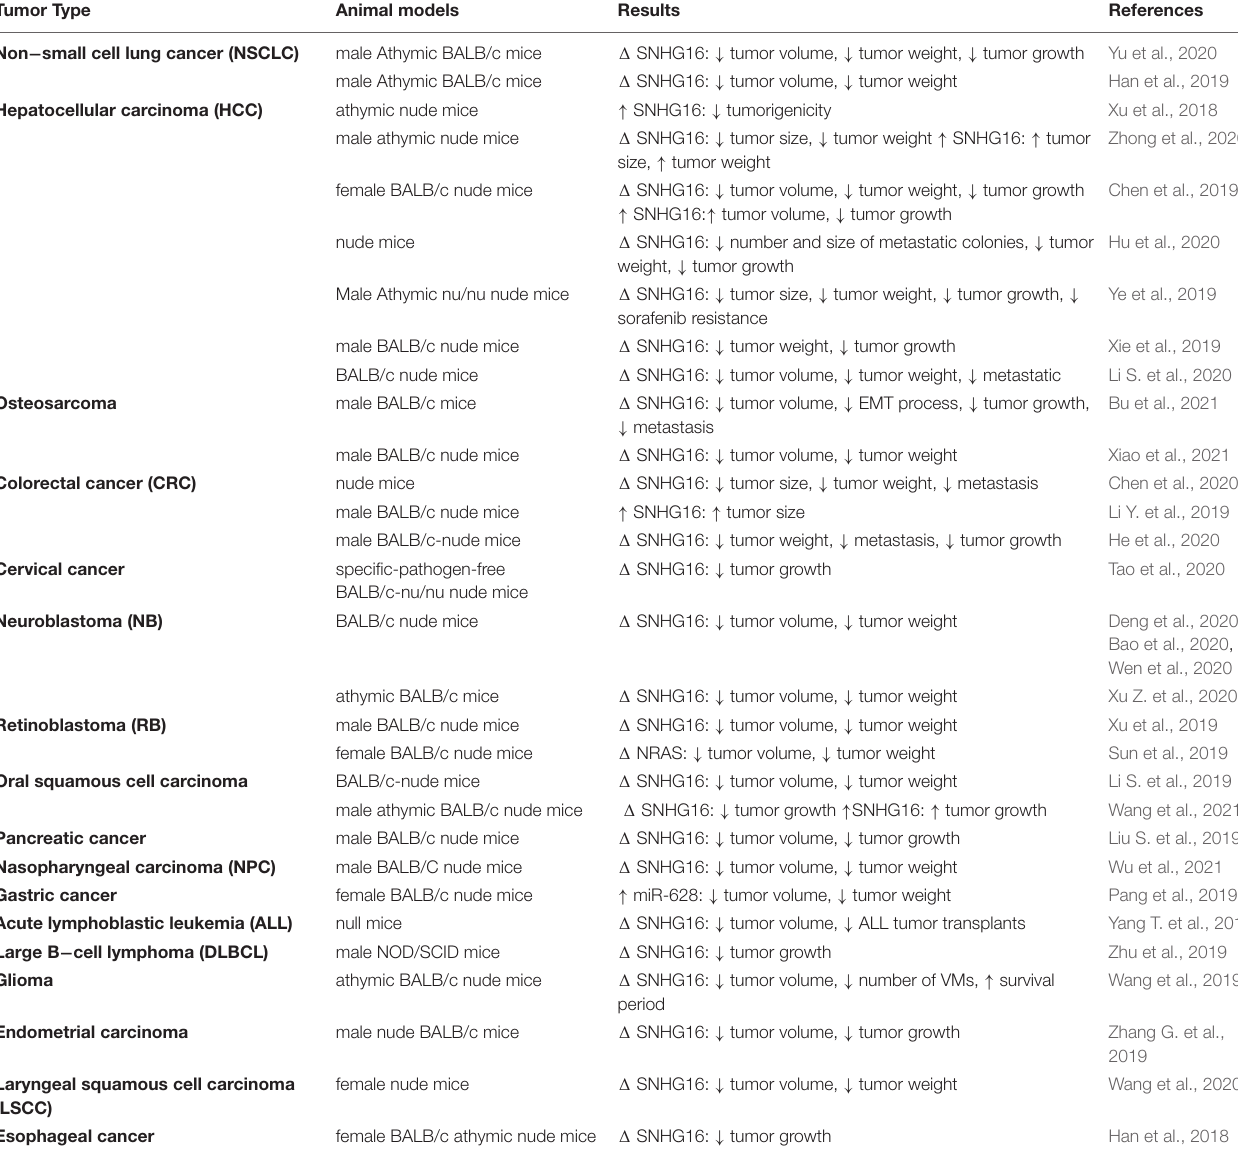
TABLE 2 | Outline of studies which judged function of SNHG16 in animal models ( (cid:49) , knock-down or deletion; VM, vasculogenic